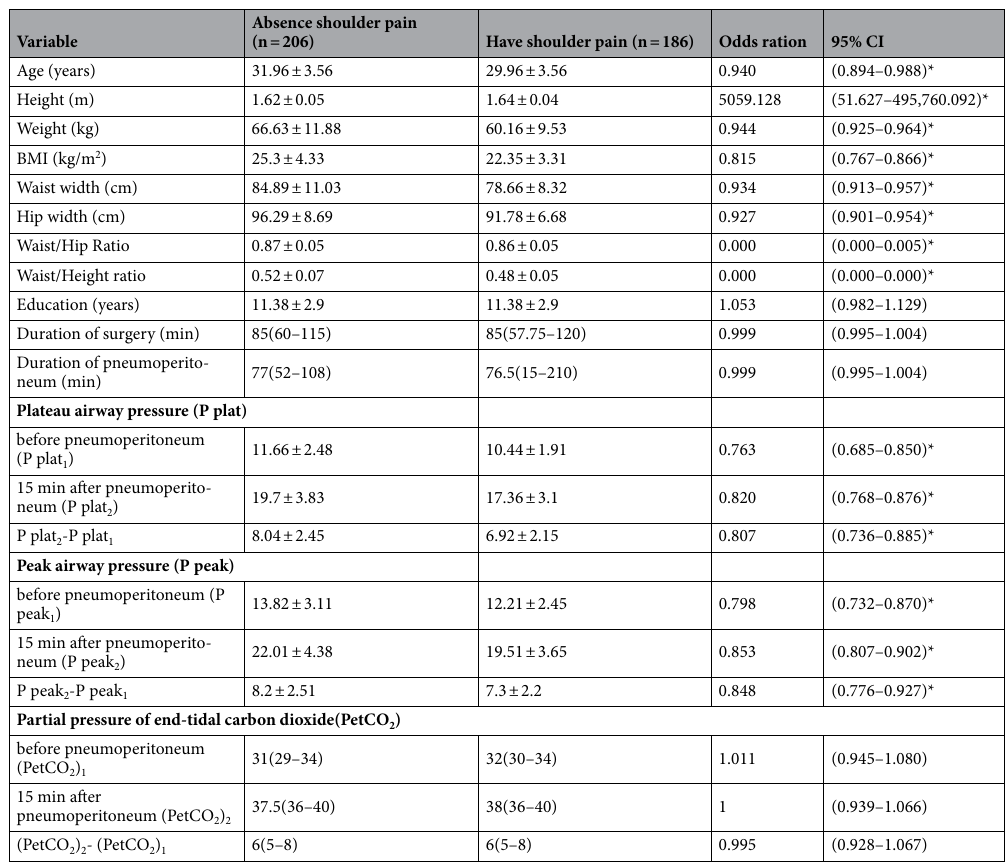
Table 2. Comparison between the two groups and univariate binary logistic regression analysis of the potential influencing factors of LPSP. Values are presented as mean ± standard deviation or median (interquartile range). * P < 0.05.